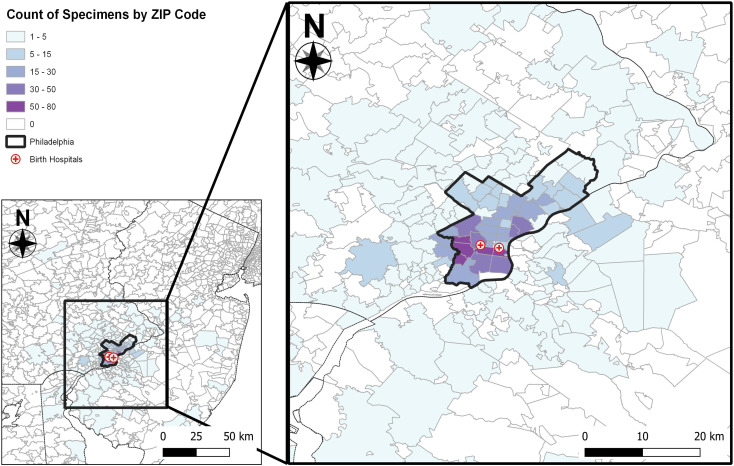
Geographical distribution of women tested for SARS-CoV-2 antibodies. Most serum specimens analyzed were from women living in areas within or immediately bordering the city of Philadelphia. Location of birth hospitals where serum samples were collected are shown as red crosses.